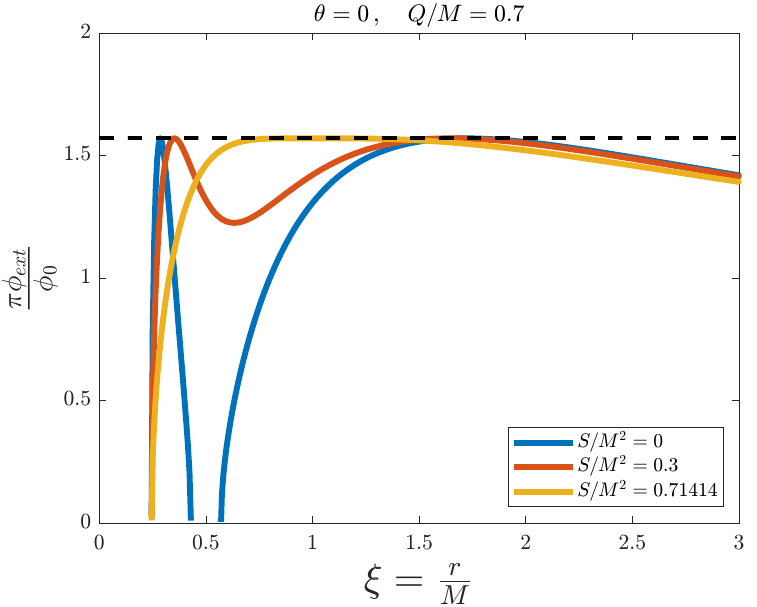
Figure 8. External magnetic flux πφ ext / φ 0 versus the adimensional distance ξ = r / M for the simulation of a Kerr–Newman black hole with fixed θ = 0 and A = Q / M = 0.7, and for different values of B = S / M 2 . The dashed line represents the threshold value πφ ext / φ 0 = π